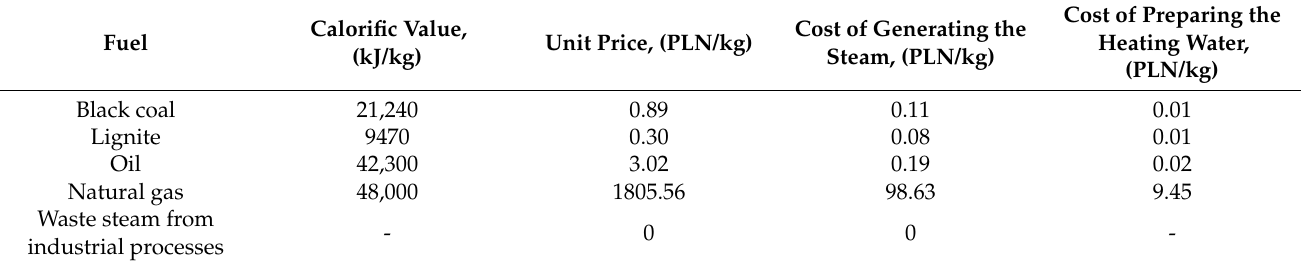
Table 5. Cost calculation of generating steam and heating water from different fuels. Based on data from [41].